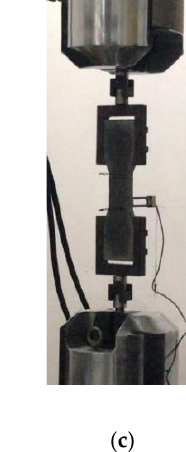
Figure 1. ( a , b ) Geometry and ( c ) test setup of uniaxial tensile test on dog-bone specimens (unit: mm).